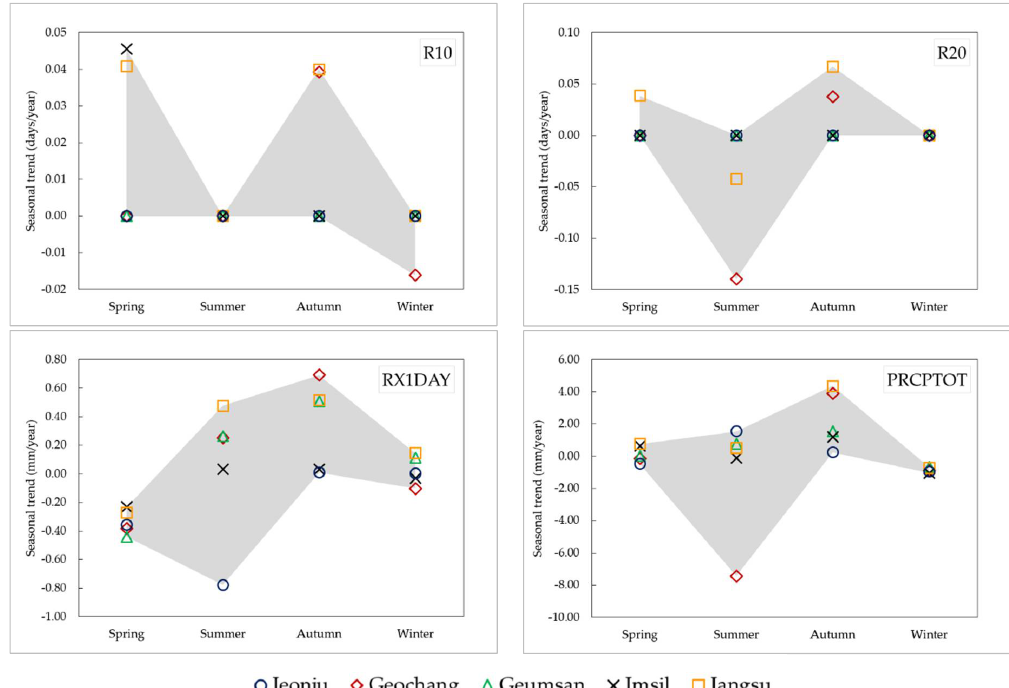
Figure 3. The seasonal trend magnitudes of the precipitation indices at the